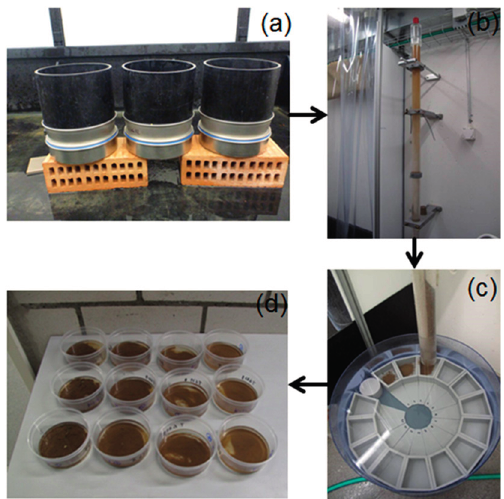
Figure 2. Experimental setup adopted in this study: ( a ) raindrop aggregate destruction test (RADT) test; ( b ) start of the settling tube (ST) test; ( c ) sample collection of each sediment fraction; and ( d ) transfer of samples from the turntable to